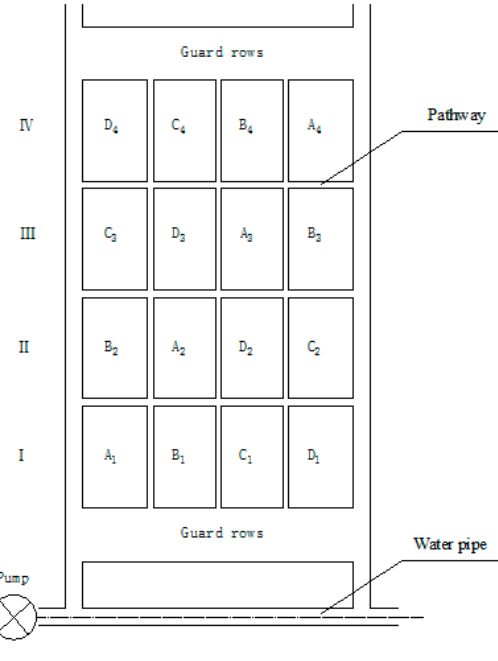
Figure 3. Layout of field plot.